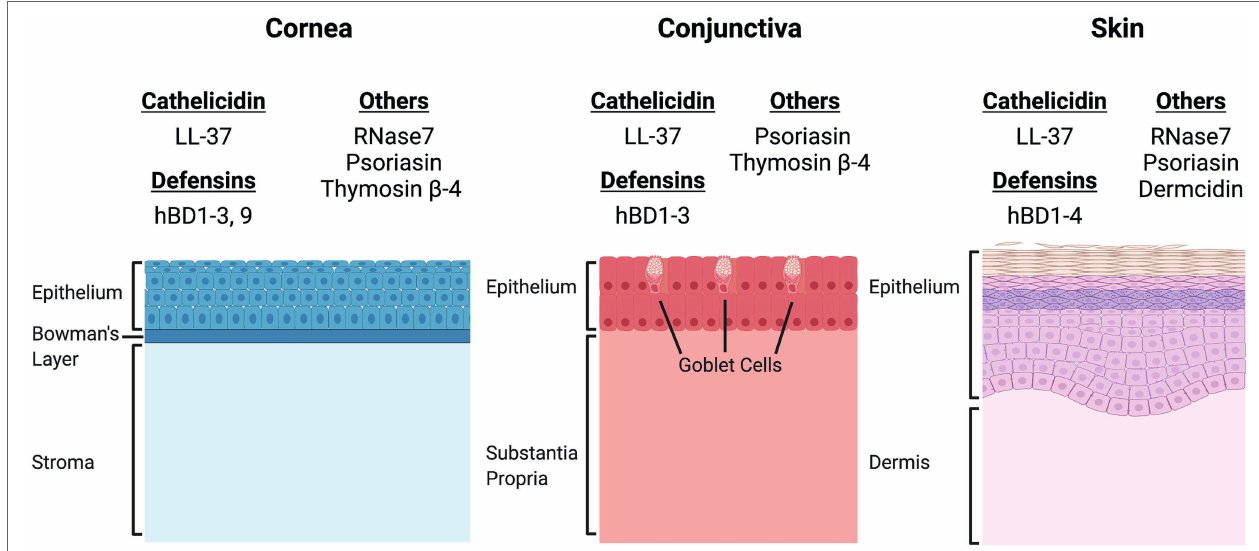
FIGURE 1 | Comparison of the site-specific expression of antimicrobial peptides (AMPs) expressed by epithelial cells of the cornea, conjunctiva, and skin. There is significant overlap in the expression patterns of AMPs at both the ocular surface and the skin. Cathelicidin (LL-37), β -defensins 1, 2, and 3, and psoriasin are expressed by epithelial cells of the cornea, conjunctiva and skin (Herman and Herman, 2019). However, site specific expression has been documented for β -defensin 4 (hBD4, skin), hBD9 (cornea), RNase7 (cornea, skin), thymosin β -4 (cornea, conjunctiva) and dermcidin (skin). The differences in AMP expression patterns may directly influence the microbial niches of the cornea, conjunctiva, and